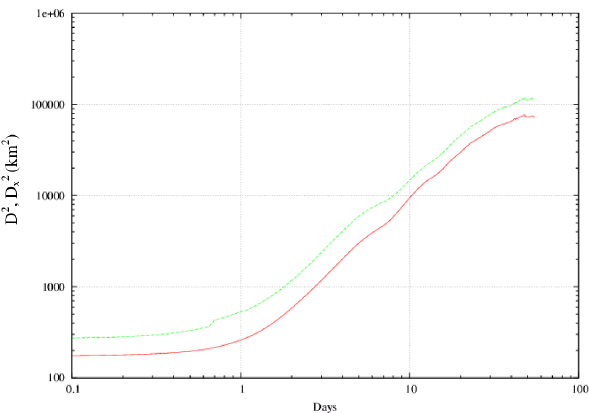
Fig. 3. The particle positions after two months of integration. In the inset we show the initial particle positions. Fig. 4a. Relative dispersion (green curve), zonal relative dispersion Figure 3 : The particle positions after 2 months of integration. In the inset, we show the initial particle positions.